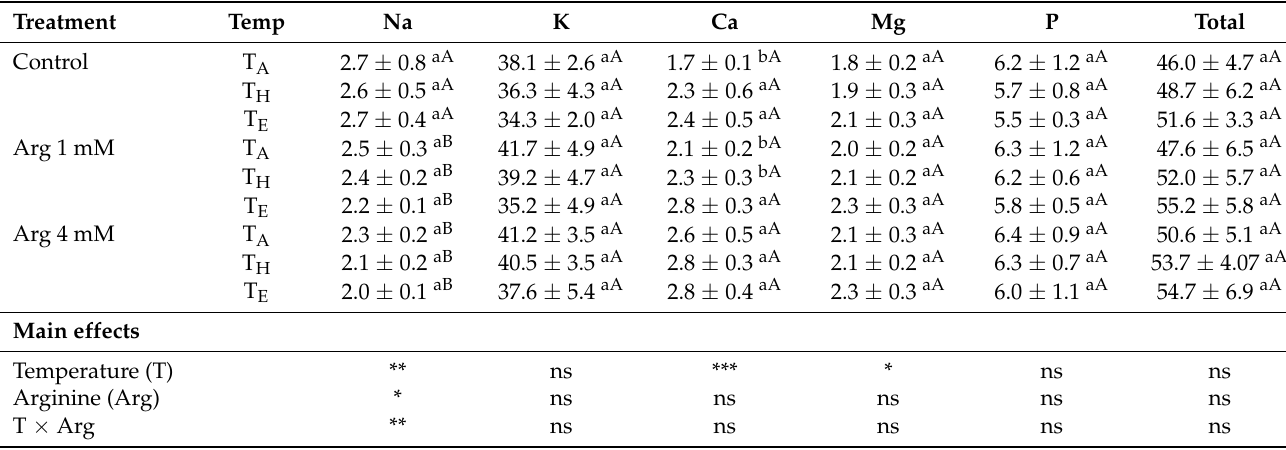
Table 2. Content of macroelements (g kg − 1 DW) of cauliflower florets as affected by short-term heat stress and foliar arginine